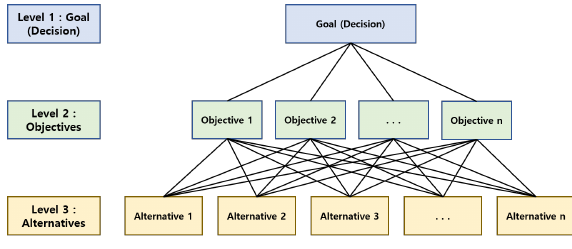
Figure 1. The structure of AHP decision making.